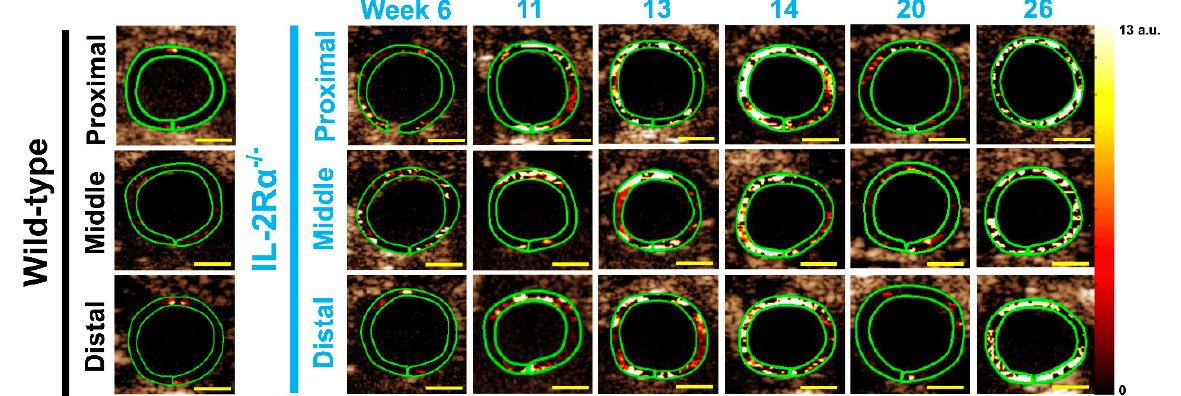
Figure 2. Axial dual P- and E-selectin targeted ultrasound molecular images of proximal, middle, and distal colon in a representative IL-2R α -/- mouse from week 6 to 26 and in a representative wild-type mouse at 6 weeks of age. Compared to the wild-type mouse, the IL-2R α -/- mouse showed substantially higher imaging signals from week 6 to 26, and the imaging signals fluctuated with being higher at week 14 and 26 than other time points. The imaging signals did not show a substantial locational difference between proximal ( top row ), middle ( middle row ) and distal colon ( bottom row ). Scale bars, 1 mm. Table 1. Mortality, frequency and onset of colitis in IL-2R α -/- mice.